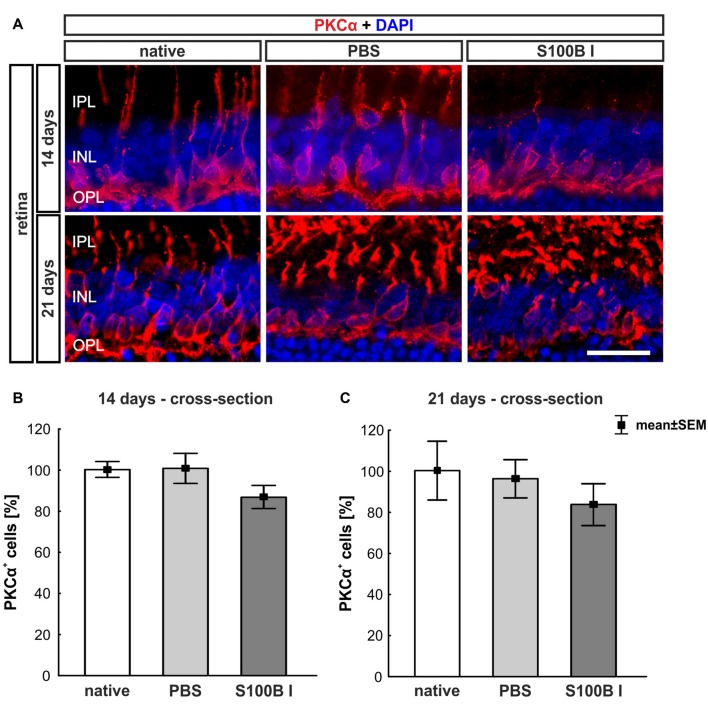
No effect on bipolar cells. (A) Exemplary images of retinal cross-sections with bipolar cell (protein kinase Cα, PKCα, red) and cell nuclei (DAPI, blue) staining were shown. (B) The PKCα+ cell count was comparable in all groups at day 14. (C) A similar result was seen at day 21. IPL, inner plexiform layer; INL, inner nuclear layer; OPL, outer plexiform layer; scale bar = 20 μm.